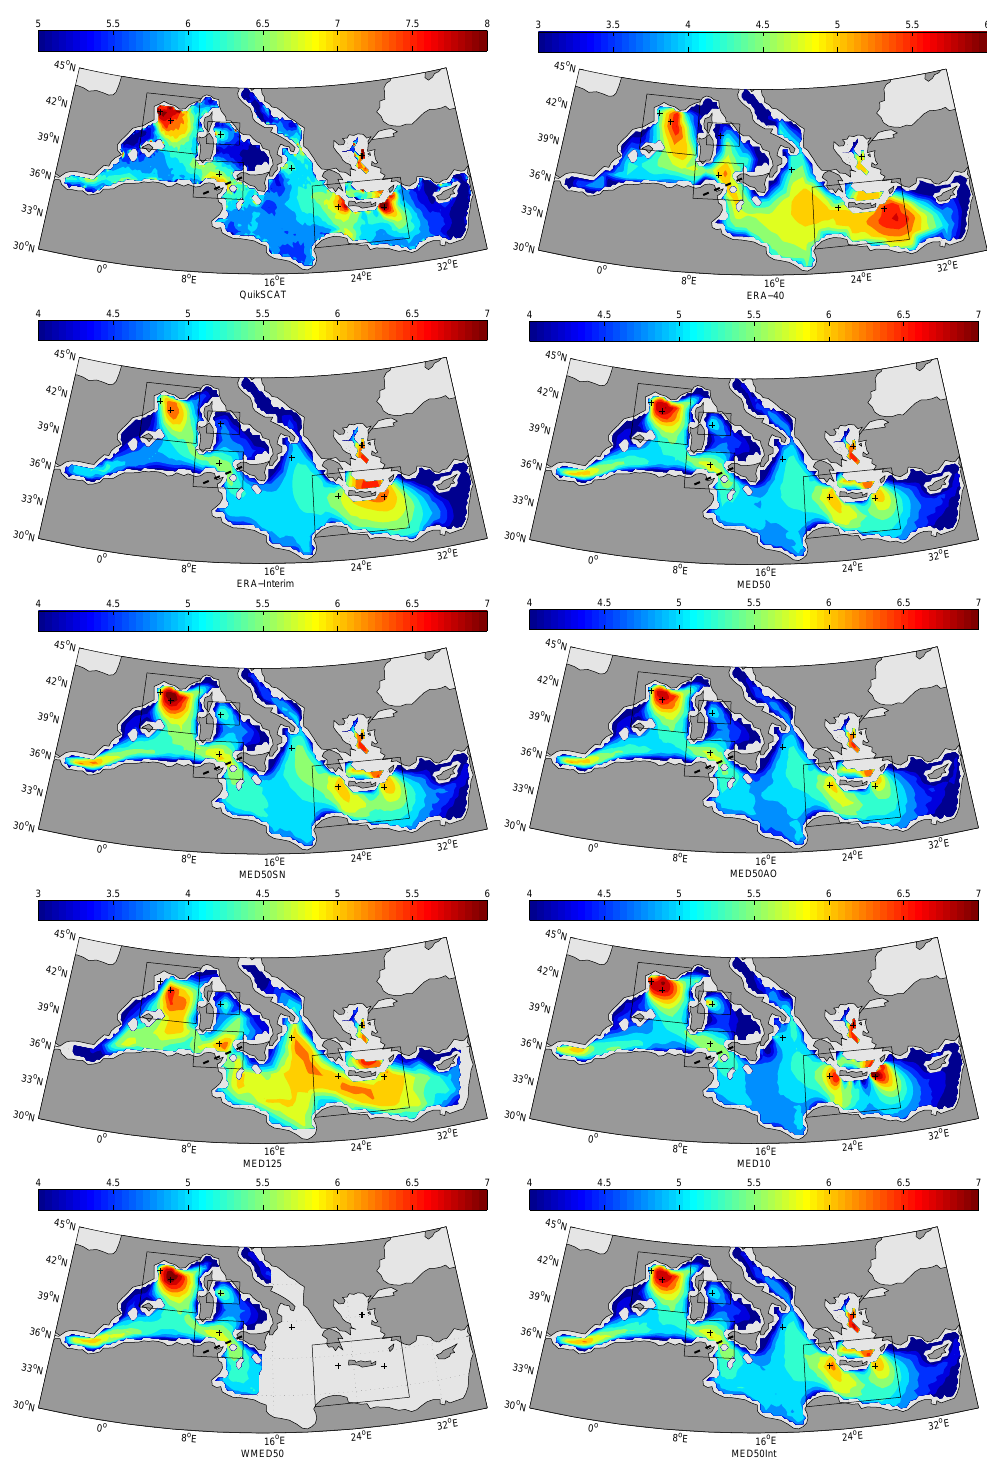
Fig. 4. Average over 2000–2001 of the daily wind speed (ms − 1 ) in QuikSCAT, ERA-40, ERA-Interim and each ALADIN-Climate simula- tion. The colorbar is not always the same for each map but its amplitude is always the same in order to highlight the similarities/differences of spatial